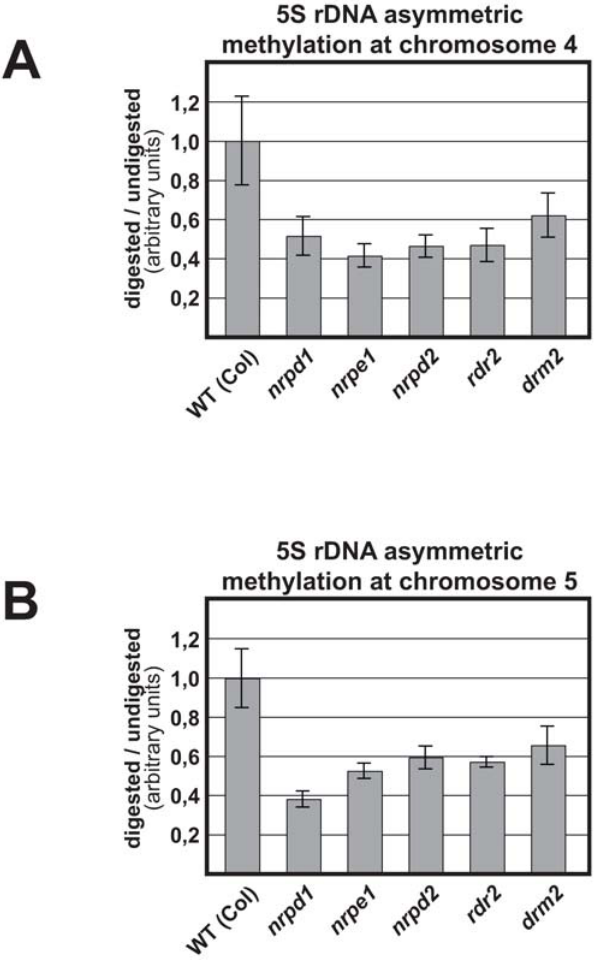
Figure 4. Asymmetric 5S rDNA methylation at chromosomes 4 and 5. DNA methylation assays using a methyl-sensitive restriction enzyme and PCR amplification were specifically performed at chromo- somes 4 and 5. PCR amplification on digested (Nla III) and undigested DNA from WT, nrpd1 , nrpe1 , nrpd2 , rdr2 and drm2 plants were performed. PCR amplification of ACTIN 2 was used to control